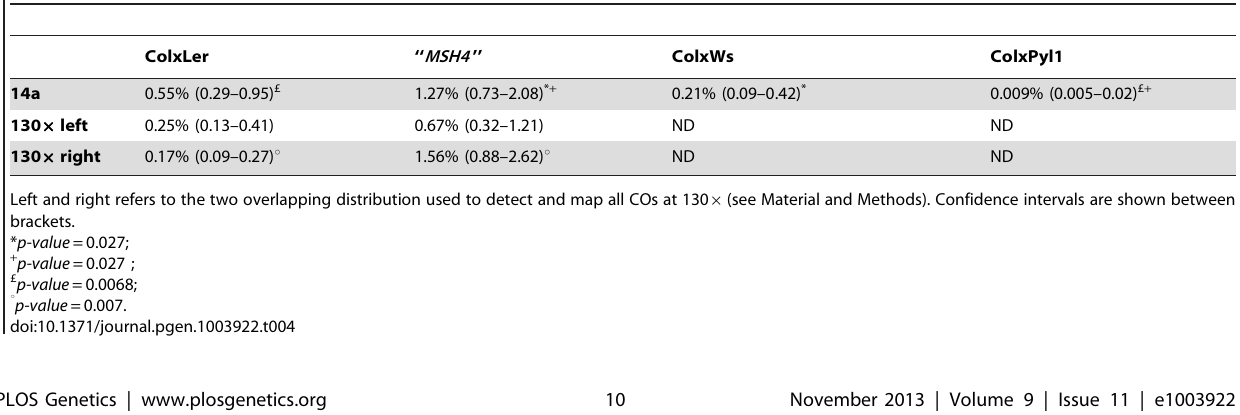
Table 4. CO rates at 14a and 130 6 in various genetic